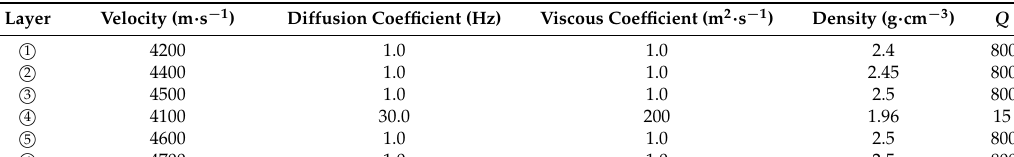
set to 30 Hz. Sampling frequency was 1000 Hz. The geological models and their corresponding seismic responses are, respectively, shown in Figures 3–5. Table 1. Main parameters for the geological models. The diffusion coefficient, viscous coefficient, and Q represent the dispersion degree of the strata, degree of viscous of fluid, and quality factor, respectively. One of the most distinct features of the gas-bearing reservoir is very low quality factor Q (5~30). The energy attenuation of the seismic signal will be more obvious when the Q value becomes lower [36].